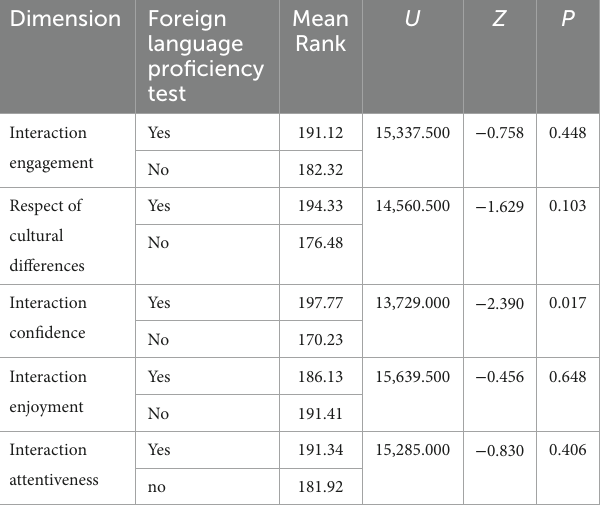
TABLE 9 Mann–Whitney U test for different dimensions according to foreign language proficiency test.